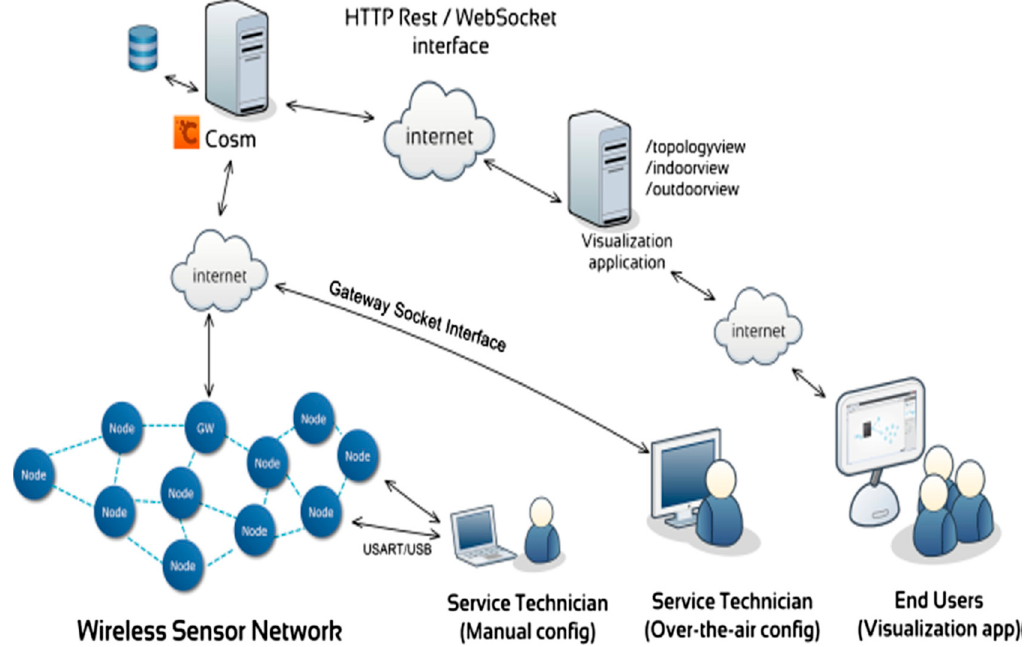
Figure 1. A wireless sensor network [76].